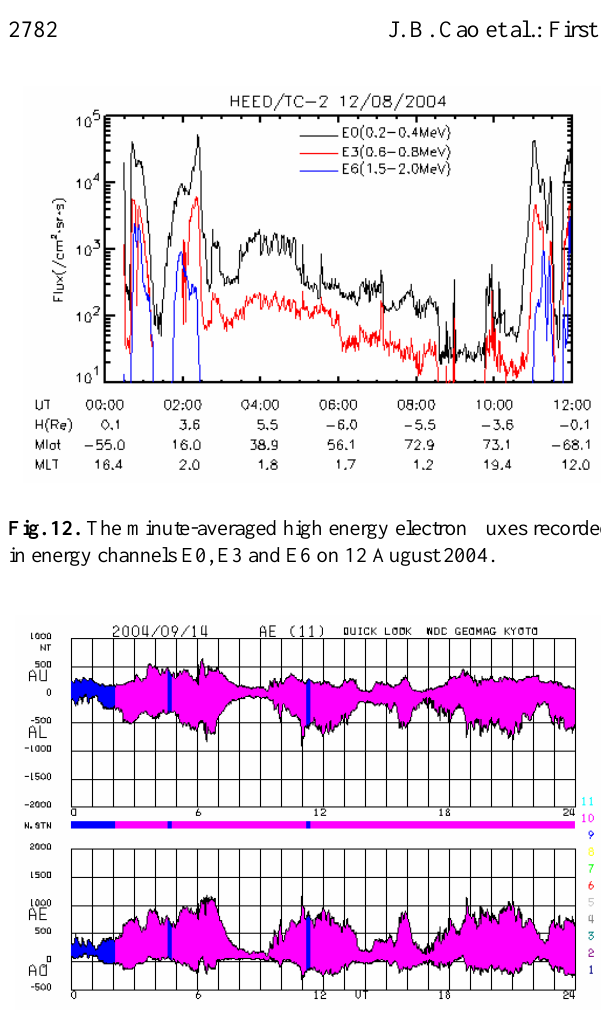
Fig. 13. Substorm A U , A L and A E index recorded on 14 September 2004.